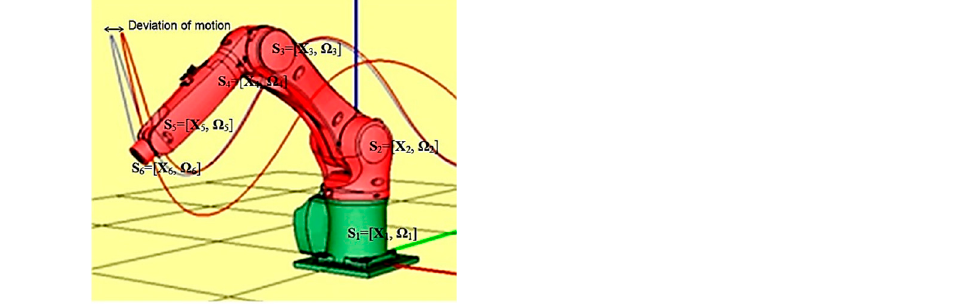
Figure 1. Deviations of movement from the set program. (S i , i = 1–6—geometric deviations in the joints).